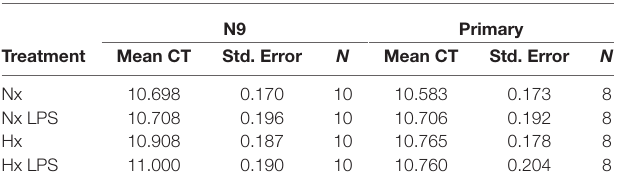
TABLE 2 | Microglial 18S CT